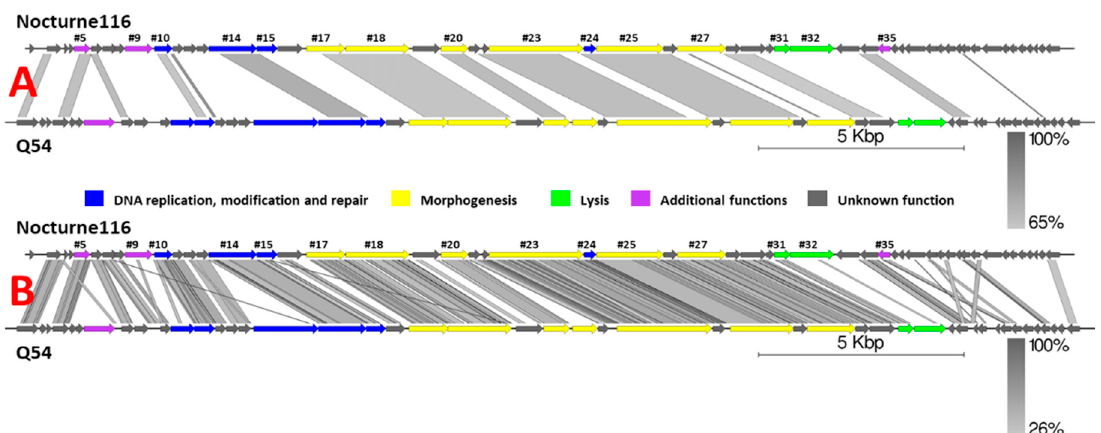
Figure 1. Pairwise genome nucleotide sequence comparison of Lactococcus phages Nocturne116 and Q54 using BLASTN ( A ) and TBLASTX ( B ). Genomes are drawn to scale; the scale bar indicates 5000 base pairs. Arrows representing open reading frames point in the direction of transcription and are color-coded based on the function of their putative product according to the legend. Gray boxes represent regions of similarity between genomes and are gradient-colored according to their identity; darker shade of gray represents higher identity. Numbers above selected arrows represent functionally annotated ORFs of Nocturne116 (Supplementary Table S1). The pairwise comparisons were carried out using EasyFig